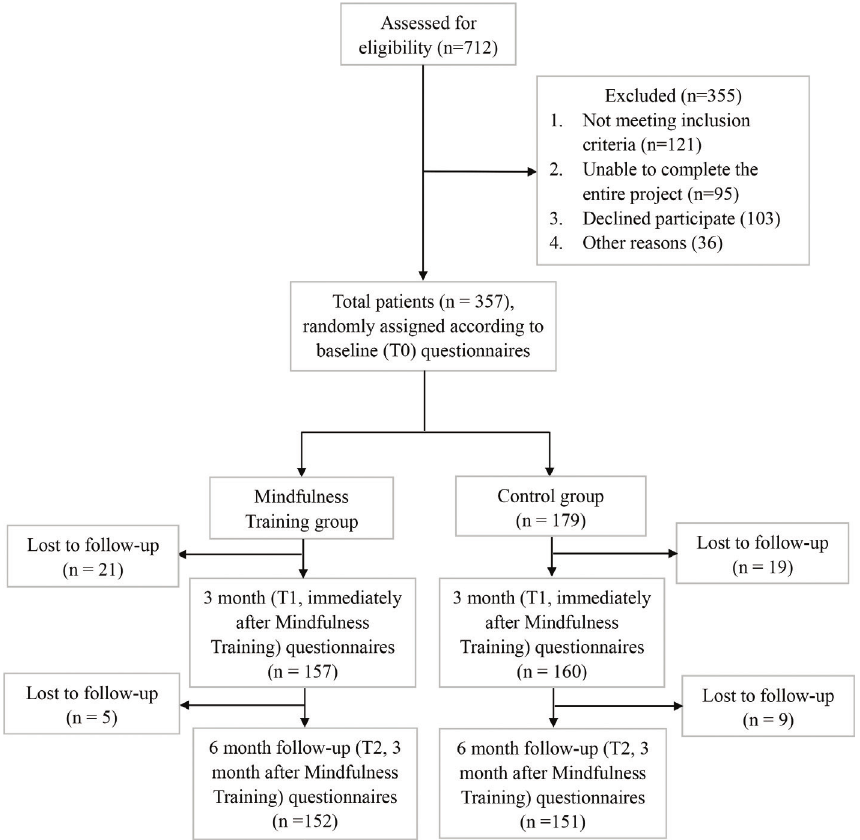
Fig. 1 . Flow diagram of the